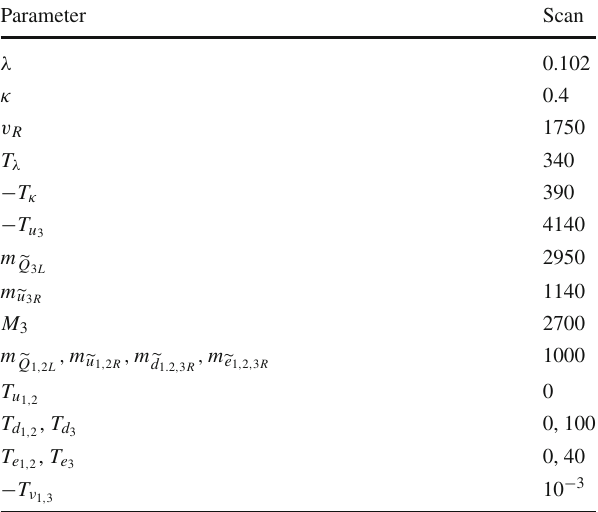
Table 3 Low-energy values of the input parameters that are fixed in the scan. The VEV v R and the soft trilinear parameters, soft gluino masses and soft scalar masses are given in GeV